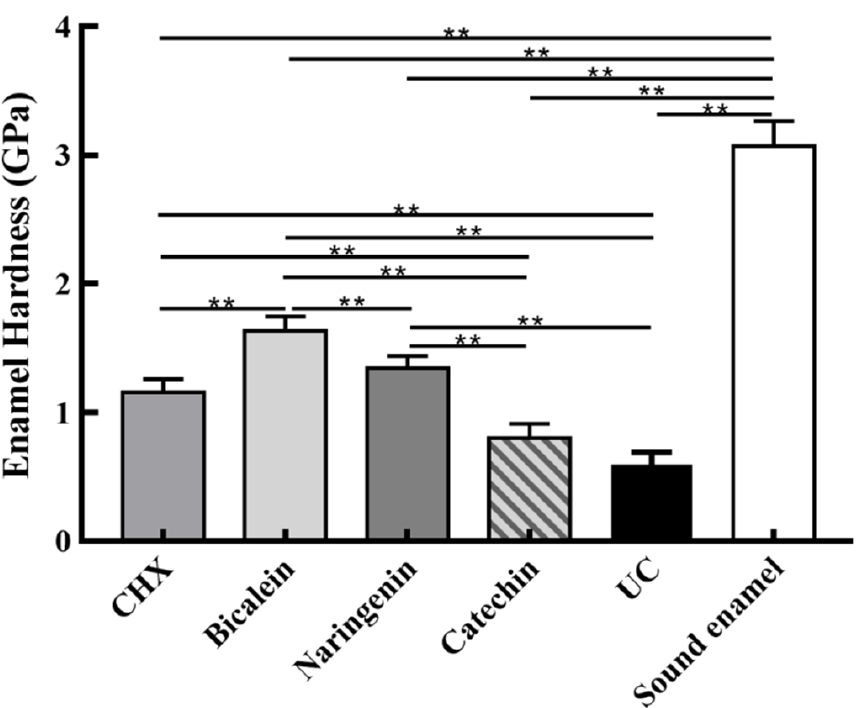
Figure 7. Enamel hardness at the enamel surface after S. mutans - C. albicans biofilm acid attack for 14 days (mean ± sd, n = 6; ** p < 0.01).